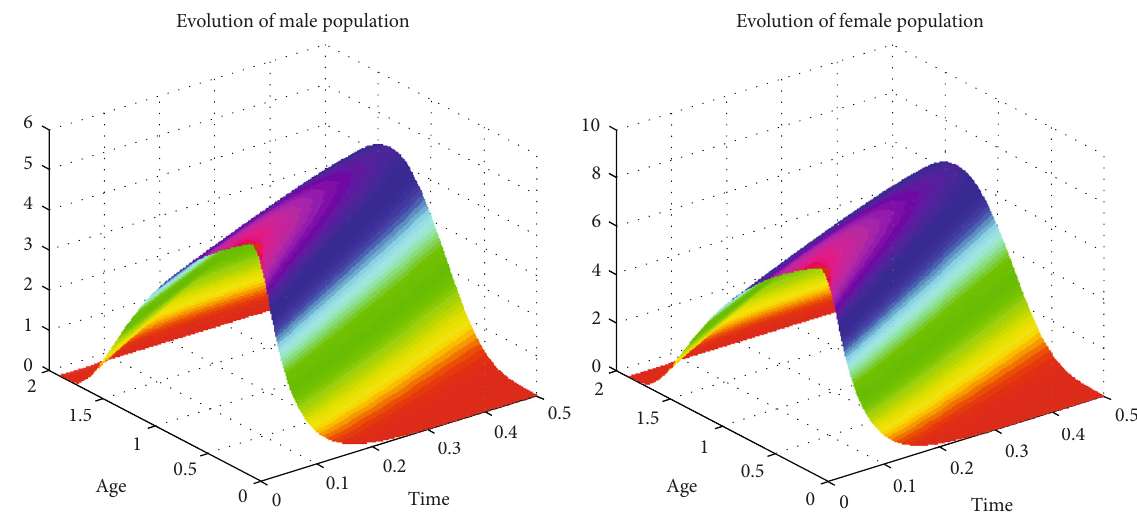
Figure 4: Evolution of the uncontrolled system from a = t = 0 to A = 2 and t = 0 : 5 .